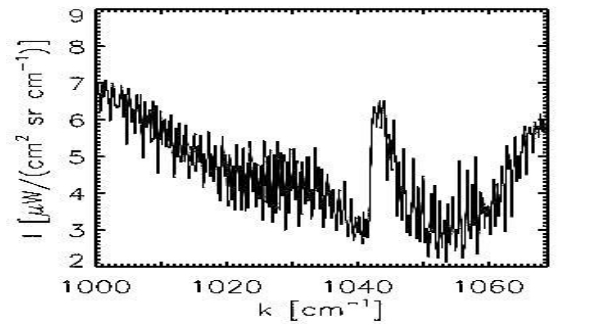
Figure 2 - The radiation spectrum in the ozone absorption band using the standard profile of America temperature and level of emissivity of 0.97 and Zenith satellite visibility angle of 10 °